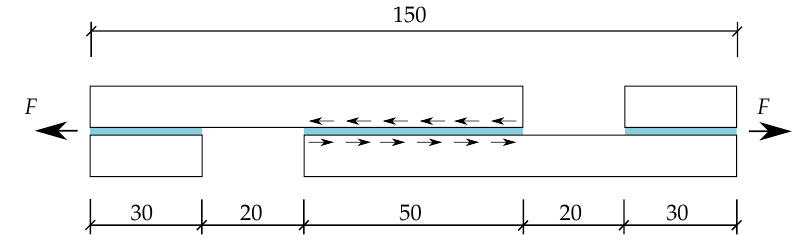
Figure 5. Nominal dimensions of the testing specimen in [mm].